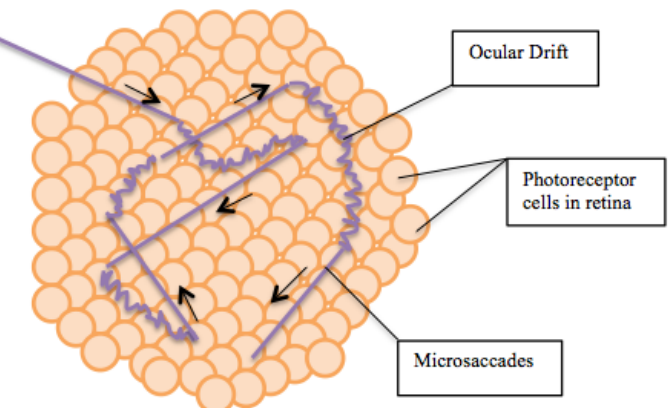
Figure 8. Microsaccades and Ocular Drifts. Adapted from Wikipedia https://commons.wikimedia. org/wiki,